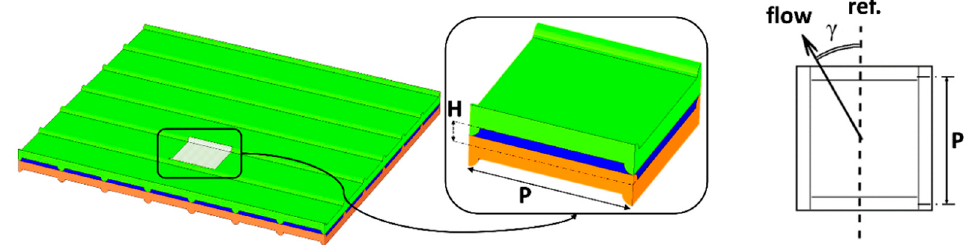
Figure 1. A channel delimited by profiled membranes of the overlapped crossed filaments (OCFs) type. A repetitive periodic unit (“unit cell”) is shown, enlarged, in the inset. The geometric parameters H (channel thickness), P (pitch), and γ (flow attack angle) are indicated. Adapted from [22].